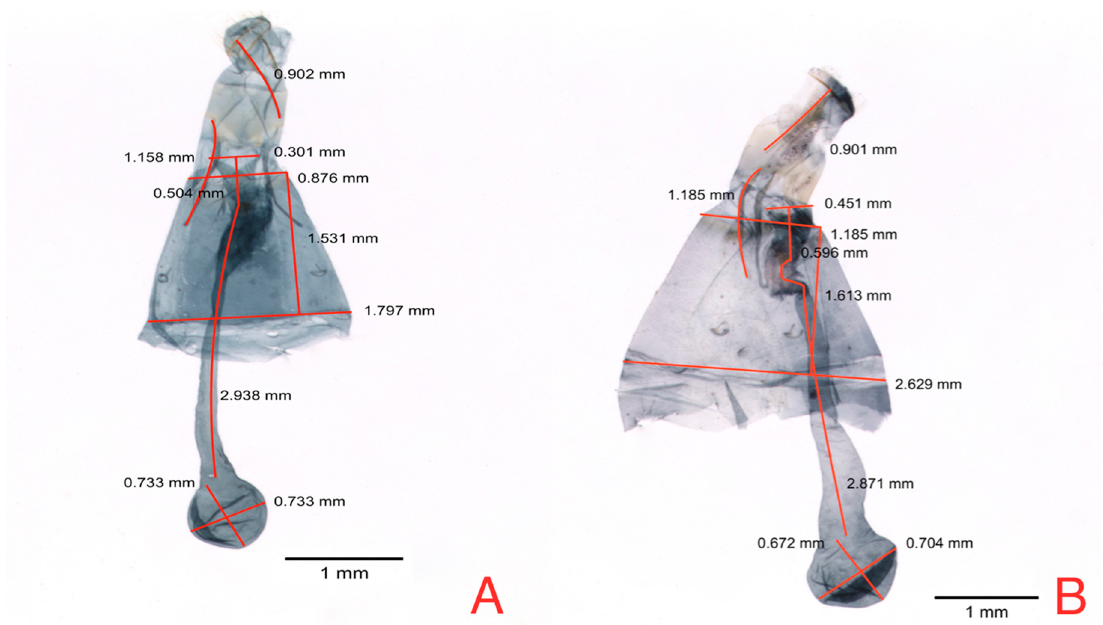
Figure 5. Morphometric differences in female genitalia of N. elegantalis from two Solanaceous hosts;